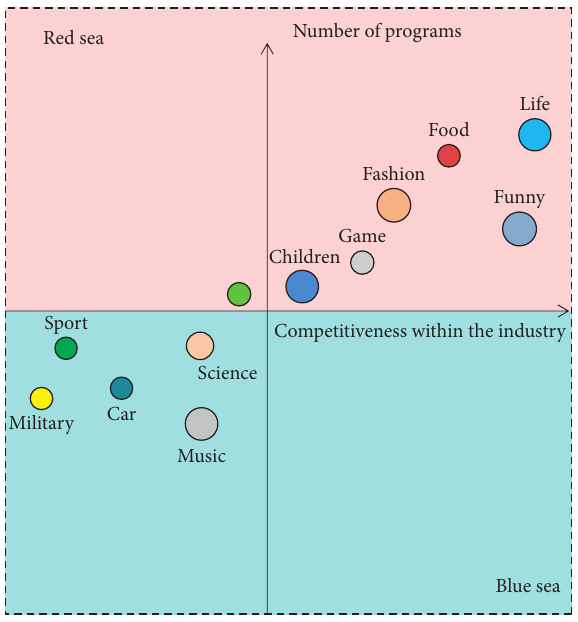
Figure 7: Short video industry vertical